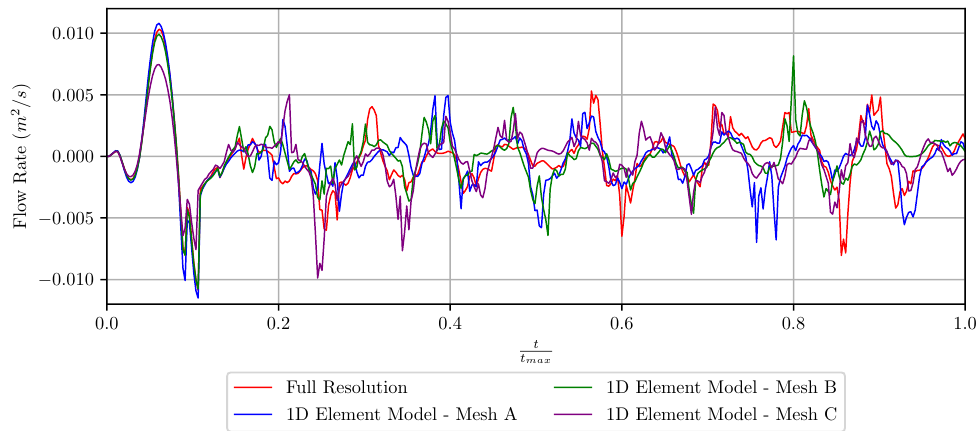
Figure 17. Flow rate through top orifice in violent slosh test case using one-dimensional orifice element model.